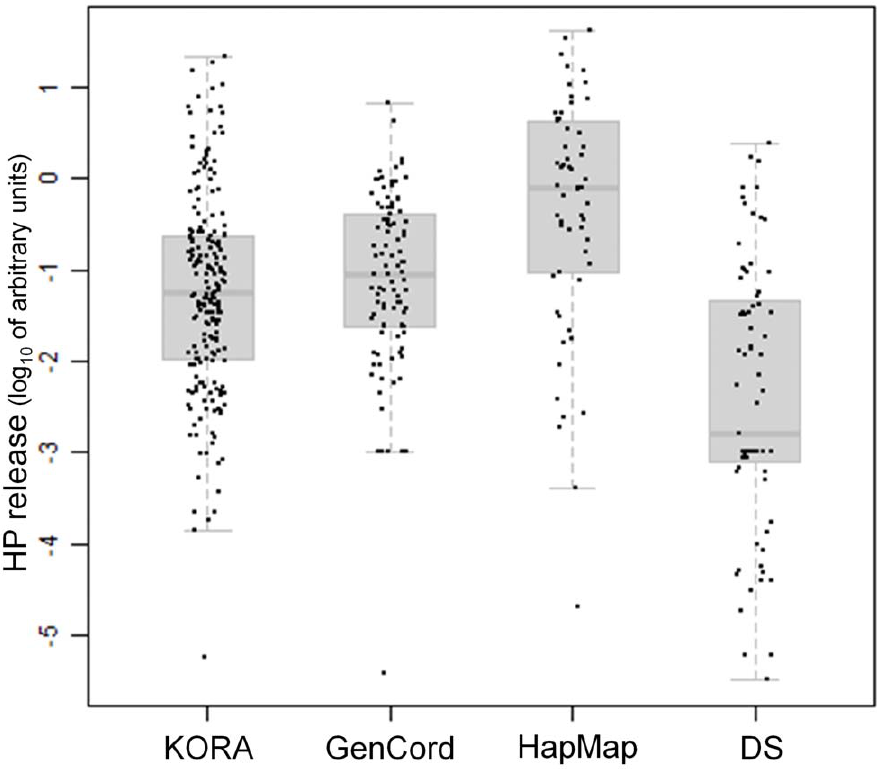
Figure 1. Distribution of H 2 O 2 release in sample cohorts KORA, GenCord, HapMap and Down Syndrome. Box plots (in light grey) for the sample cohorts KORA, GenCord, HapMap and Down Syndrome (DS) show the distribution of H 2 O 2 variation across cohorts. Each black dot corresponds to an individuals’ mean of 4 measures of H 2 O 2 release. The median is shown as a dark grey line, the low and upper end of the box plots (in light grey) indicate the first and third quartile of the distribution. The whiskers indicate the lower and upper end of the distribution The distribution of H 2 O 2 in the Down Syndrome cohort shows a significant decrease as compared to HapMap (Wilcoxon rank sum test, p , 2.88 6 10 2 12 ).